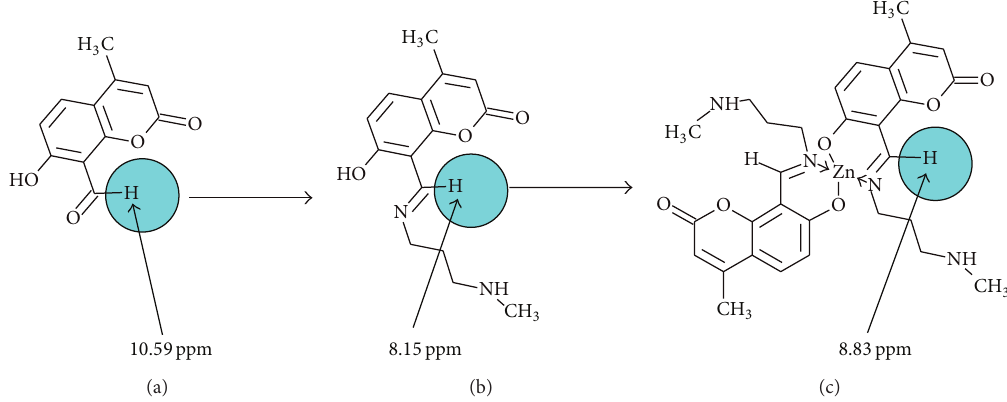
Figure 1: Azomethine proton shift values before and after complexation with Zn(II) metal